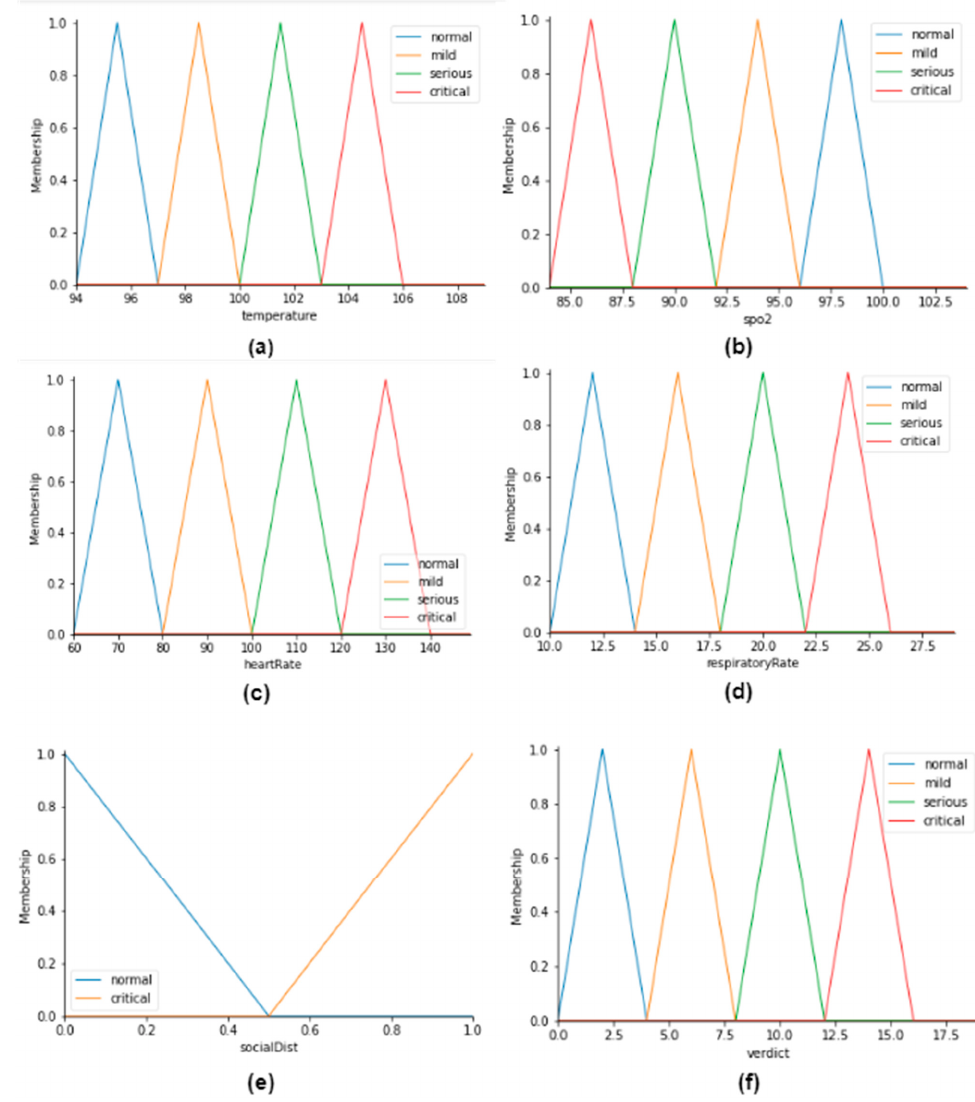
Figure 6. The membership function for ( a ) Temperature, ( b ) SpO 2, ( c ) Heart Rate, ( d ) respiratory Rate, ( e ) Social Distancing, and ( f ) verdict.